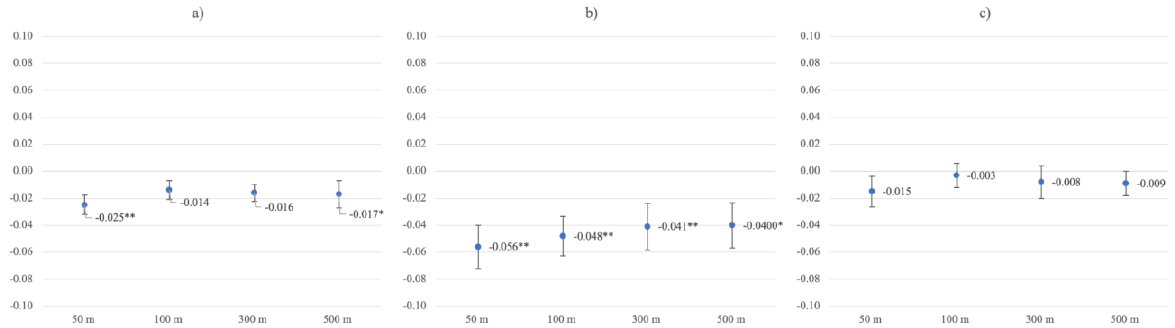
Figure 3. Greenspace ß coefficients with standard errors for unadjusted depressive symptoms models in the ( a ) whole sample, ( b ) non-working group, and ( c ) working group. * Statistical significance at p ≤ 0.05. ** Statistical significance at p ≤ 0.01. Table 2. Associations between residential greenspace at 50m, 100m, 300m, and 500m buffers, and depressive symptoms (whole sample/population).